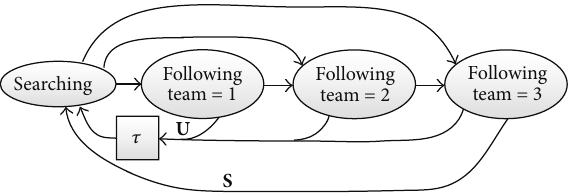
Figure 3: The Petri-net diagram of multirobot cooperative hunting